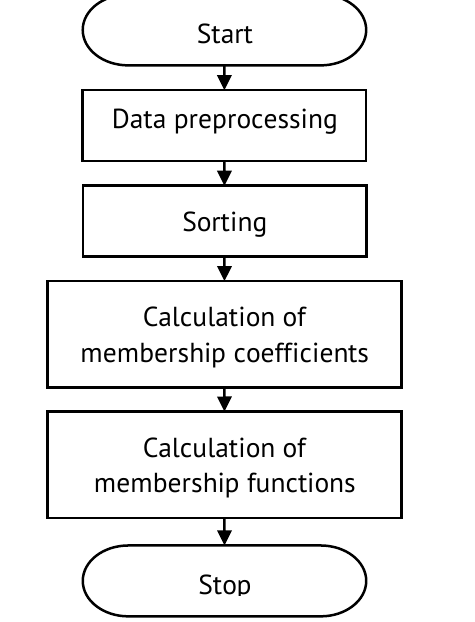
Figure 1. Algorithm for the identification of membership